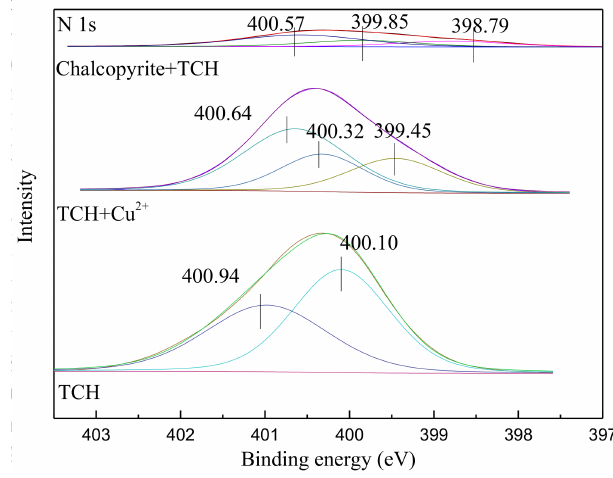
Figure 8. N 1s spectra of TCH, TCH–Cu 2+ and chalcopyrite after treatment.